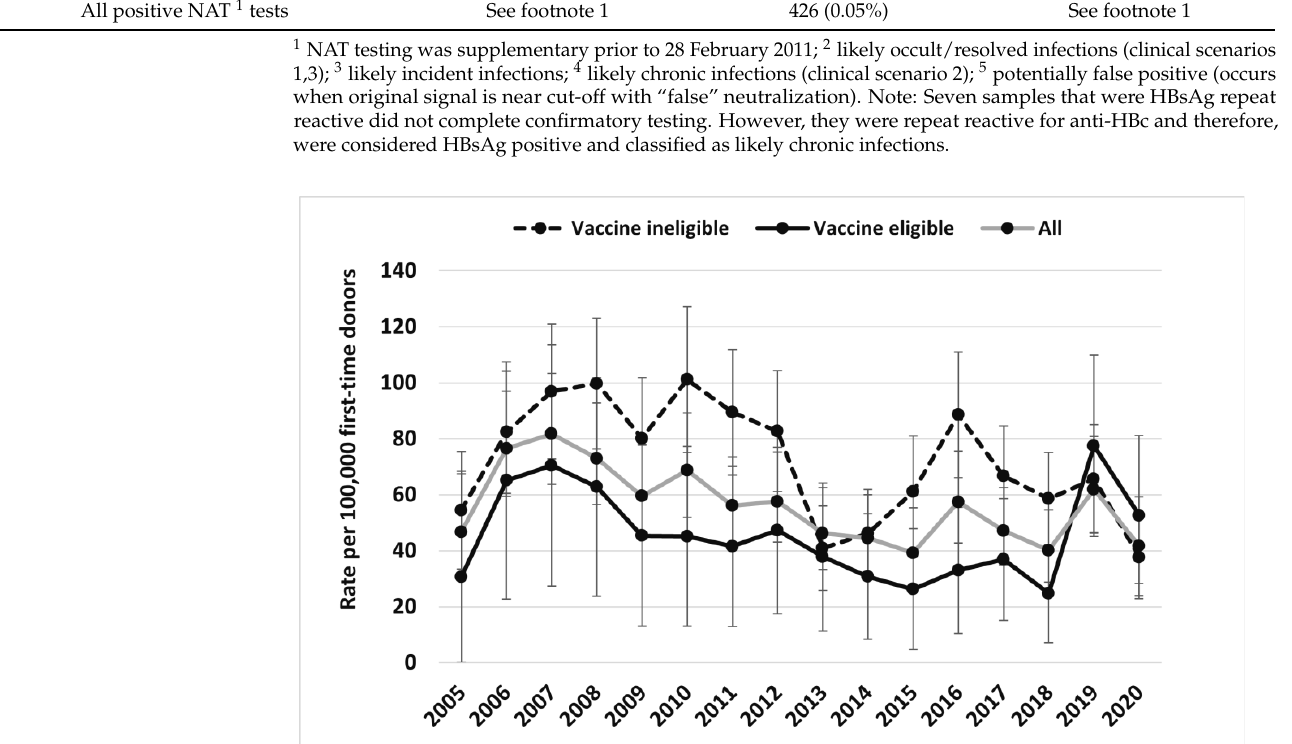
Figure 2. HBV clinical scenarios 1/3 (likely resolved/occult infection) rate (per 100,000 first-time do- nors) (95% confidence intervals) by vaccine age eligibility based on provincial routine programs from 2005 – 2020.